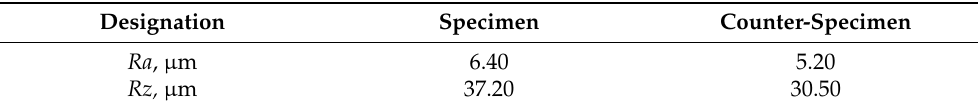
Table 3. Average roughness parameters of surfaces on the area of contact for specimen and counter- specimen after the wear